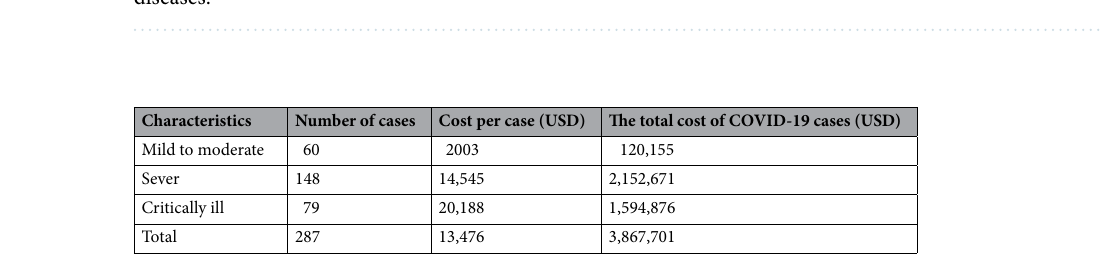
Table 4. The estimated financial burden to the national health insurance for COVID-19